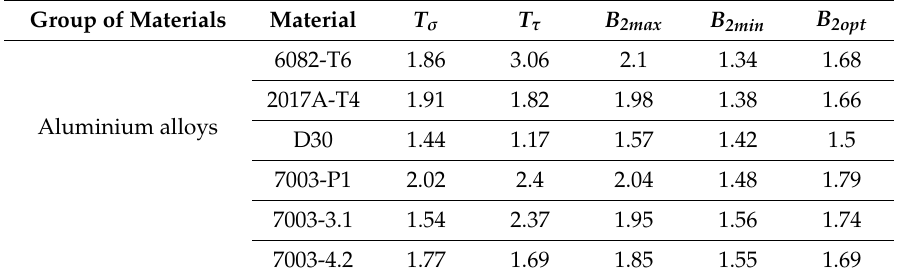
Table 6. Values of scatter for oscillatory bending (T σ ) and bilateral torsion ( T τ ). Group of